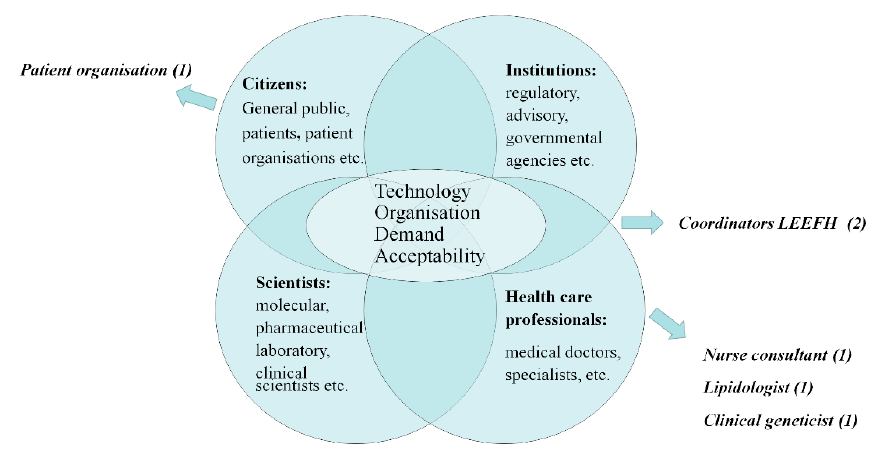
Figure 1. Network of stakeholders that need to be attuned in transition processes that could be initiated by dynamics in technology, organization, demand, and/or acceptability in healthcare systems (adapted from Rigter et al., 2014, [19] and Achterbergh et al., 2007, [18]). Table 1. Stakeholders interviewed.